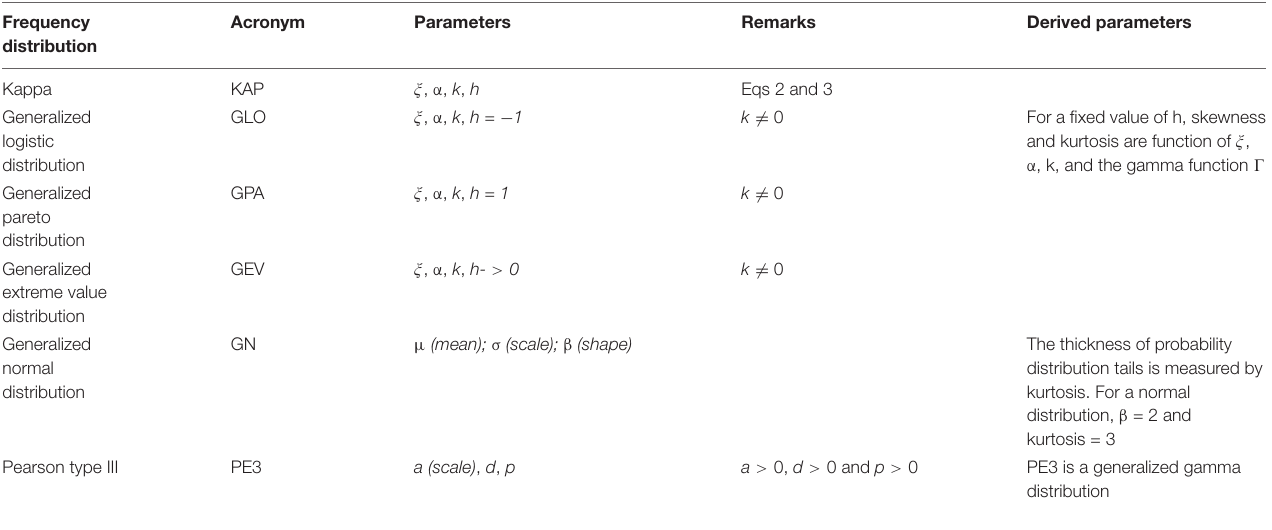
TABLE 1 | Definition of frequency distribution